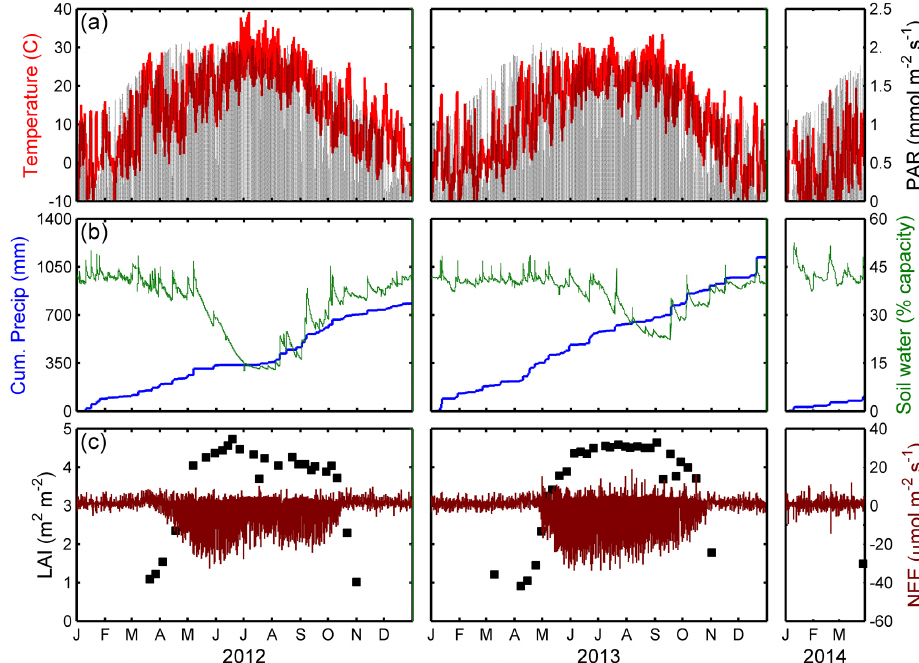
Figure 3. Overview of conditions at MMSF during 2012 to March 2014. (a) Hourly average air temperature (at 46m) ( ◦ C) and photosyn- thetically active radiation (PAR) (mmolm − 2 s − 1 ) . (b) Cumulative precipitation (Cum. Precip) (mm) by year, day, and daily soil water (% capacity). (c) Mean leaf area index (LAI) during the vegetation system derived from measurements along three transects radiating from the tower along with the hourly net ecosystem exchange (NEE) (µmolm − 2 s − 1 )